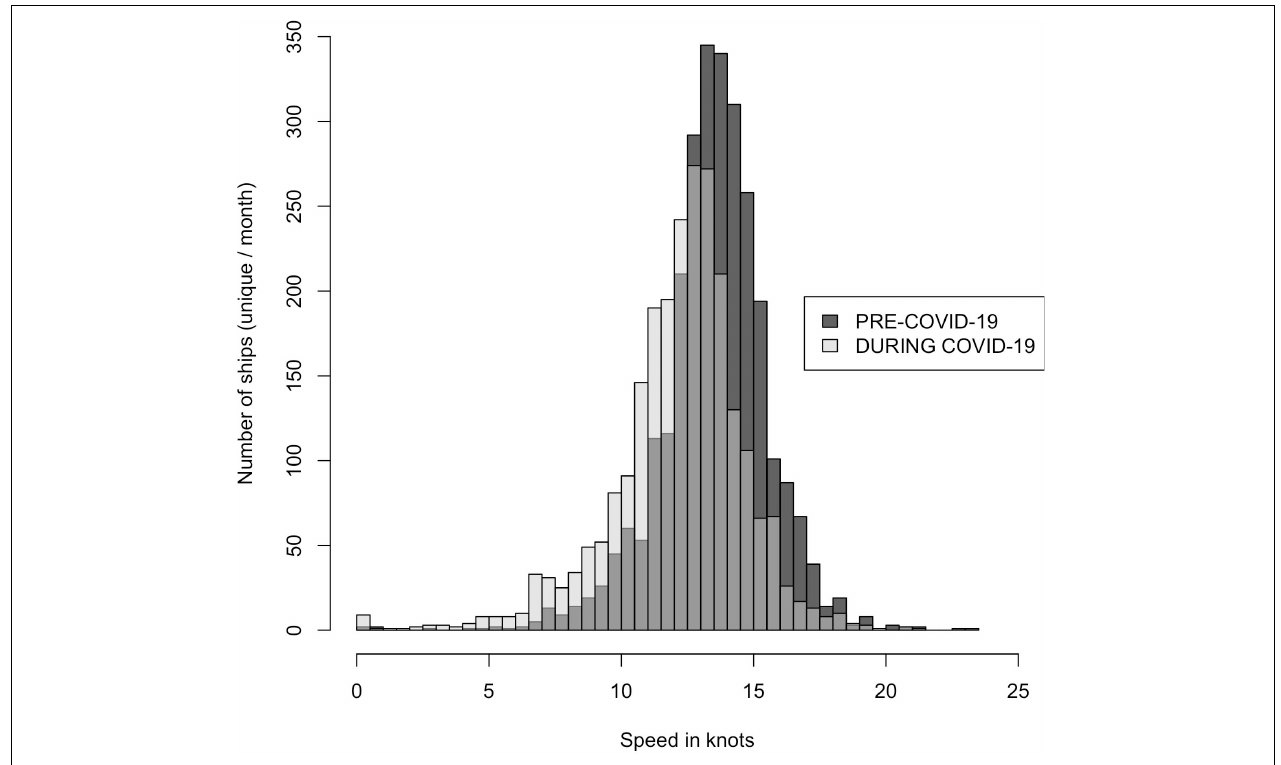
FIGURE 3 | A histogram presenting the number of ships/months and the mean ship speed for each unique ship per month PRE-COVID-19 (dark gray, n = 2,781) and during COVID-19 (light gray, n = 2,439). The gray central area is where the datasets